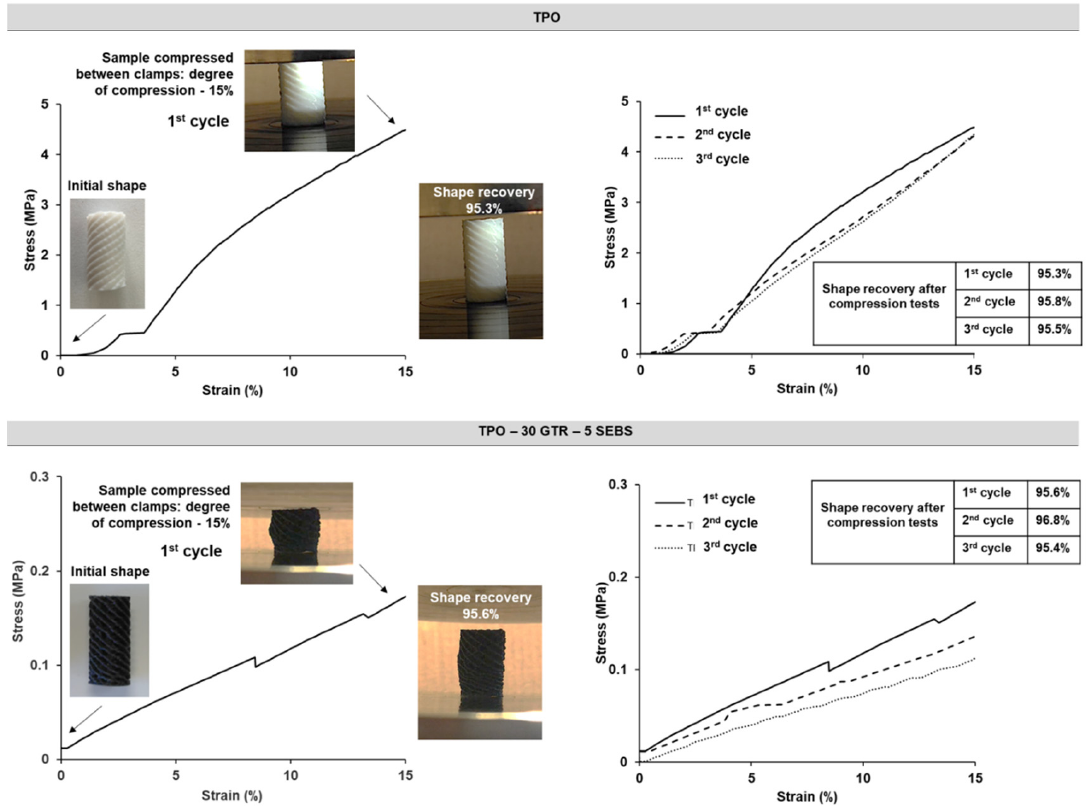
Figure 12. Stress–strain compression curves: first cycle of compression and digital images of the samples (on the left) and reproducibility of the compression tests (three successive fatigue cycle tests; on the right) of TPO and TPO-30 GTR-5 SEBS samples.